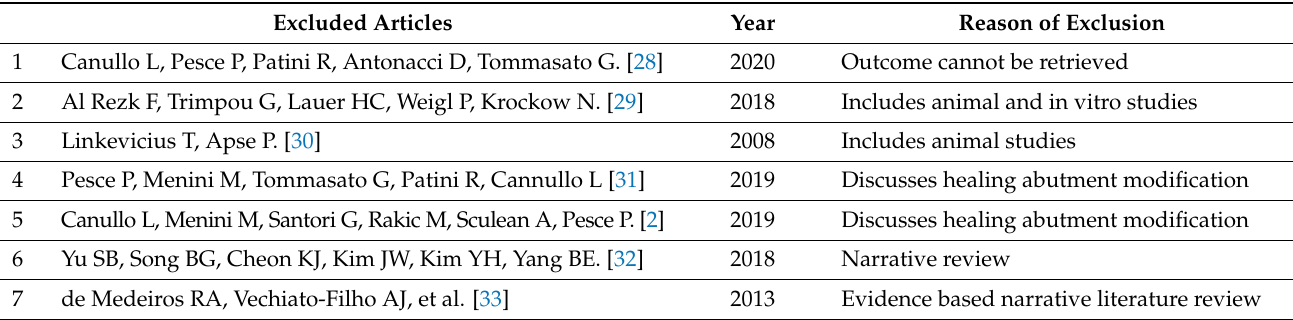
Table 1. The table shows reasons for exclusion of 7 articles after reading the